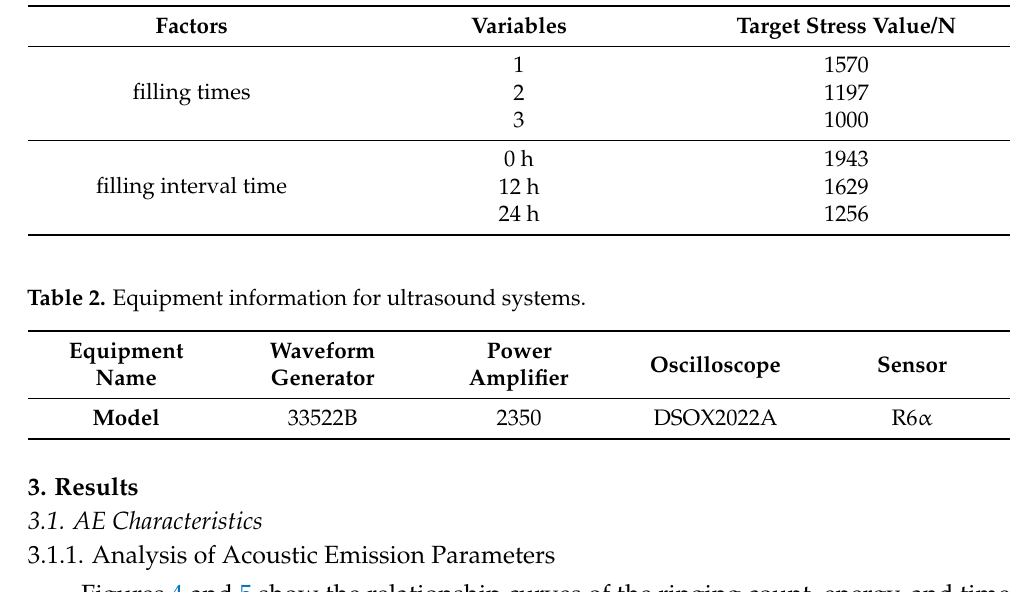
Figure 3. Schematic diagram of the experimental process.